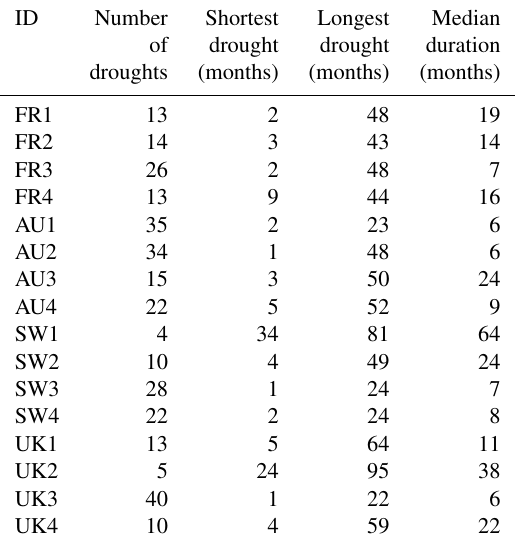
Table 2. Summary table of number of droughts and drought dura- tion (in months) for each site for the period